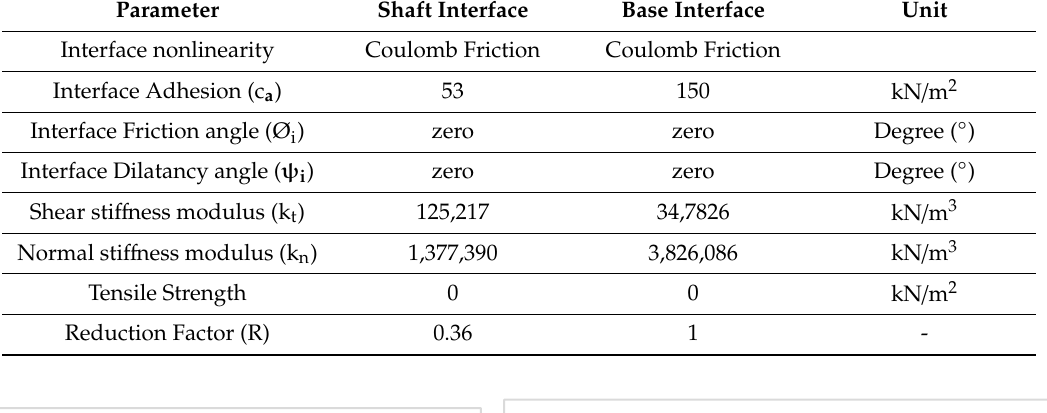
Table 4. Interface elements parameters.